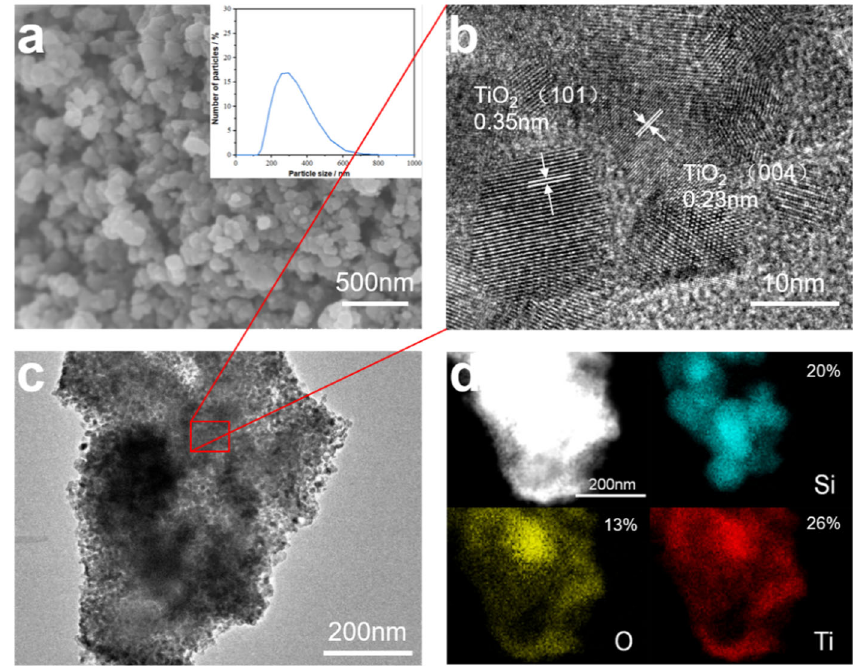
Figure 3. ( a ) SEM image of SiNPs@TiO 2 , whose upper right inset shows the particle size distribution of SiNPs@TiO 2 , ( b ) HRTEM image, ( c ) TEM image, and ( d ) EDS